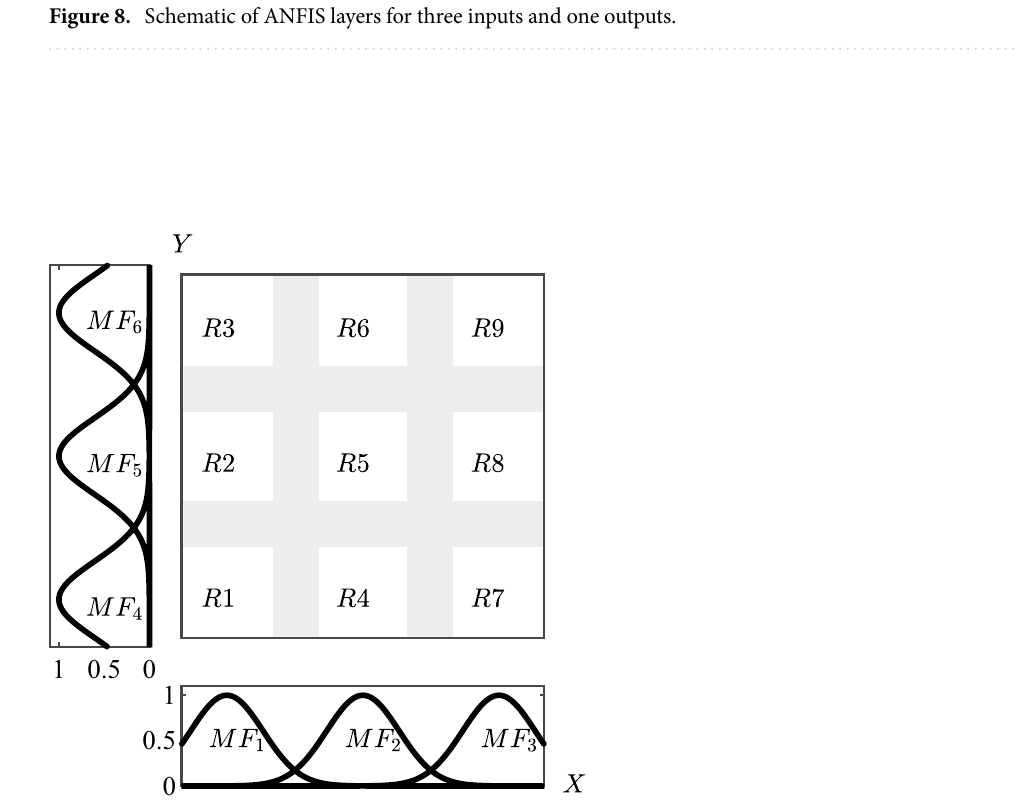
Figure 9. Fuzzy subspaces for ANFIS with two-inputs and three